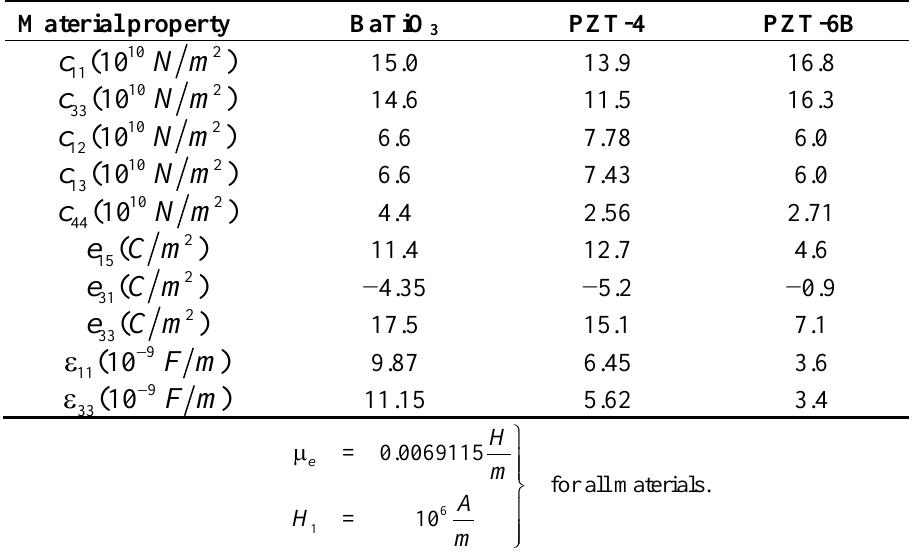
Table 1. Material Properties of Piezoelectric Materials.